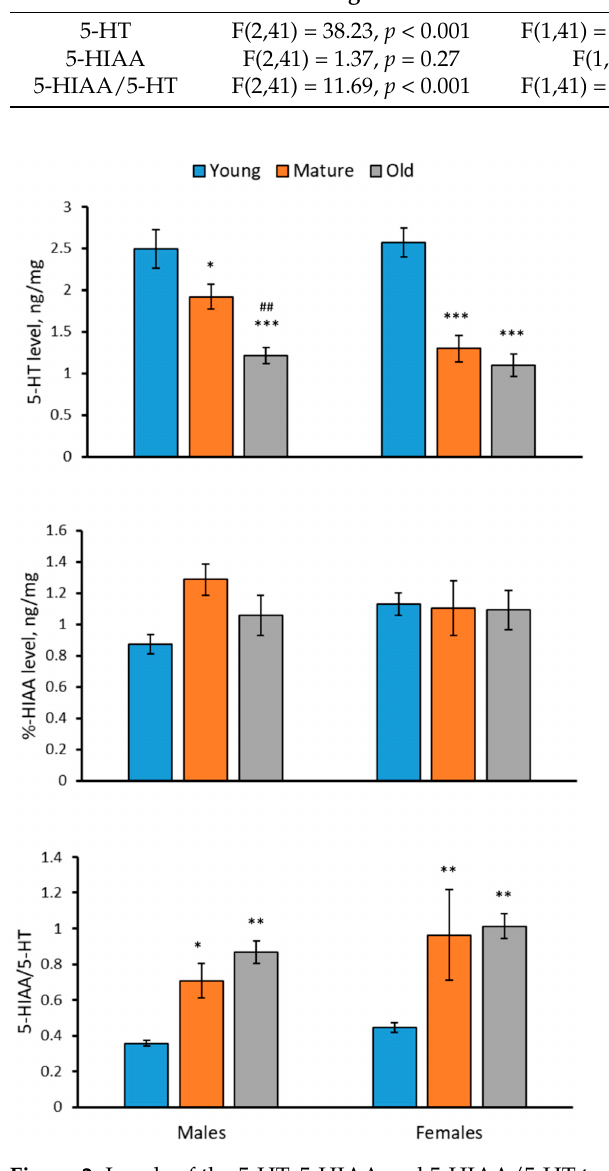
Figure 2. Levels of the 5-HT, 5-HIAA and 5-HIAA/5-HT turnover rate in the brain of 2 (young)-, 4 (mature)- and 7 (old)-month-old male and female N. furzeri . * p < 0.05, ** p < 0.01, *** p < 0.001 vs. young fish of the same sex; ## p < 0.01 vs. mature males.